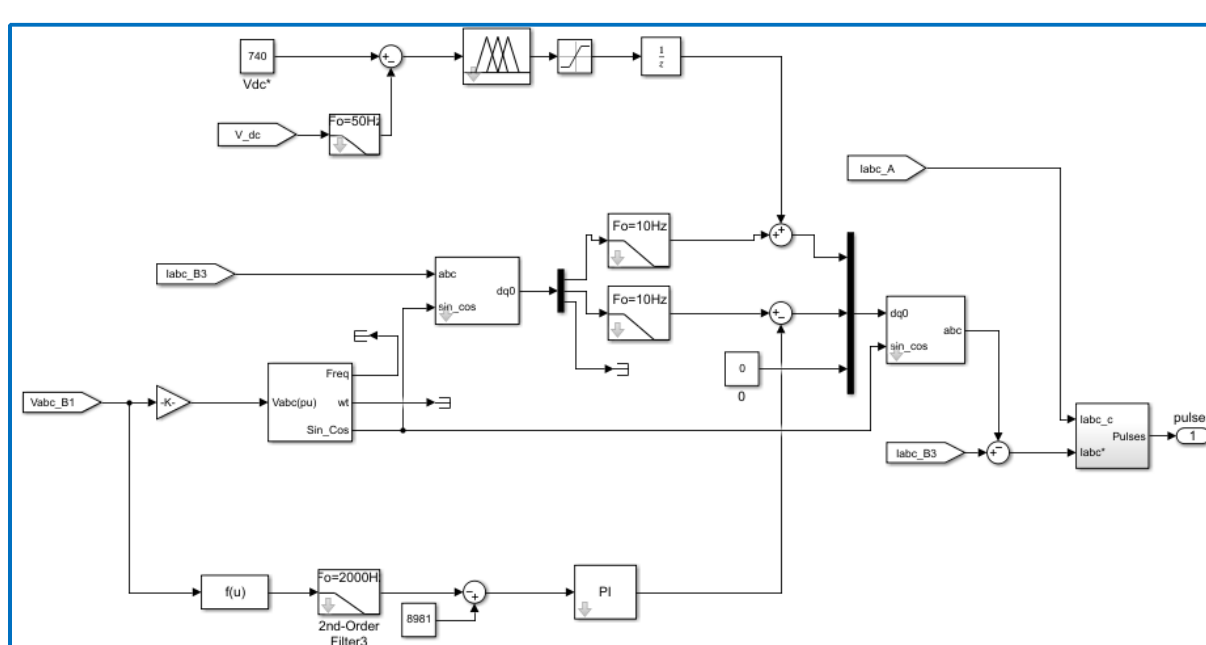
Figure 6. Simulink model of D-STATCOM controller.